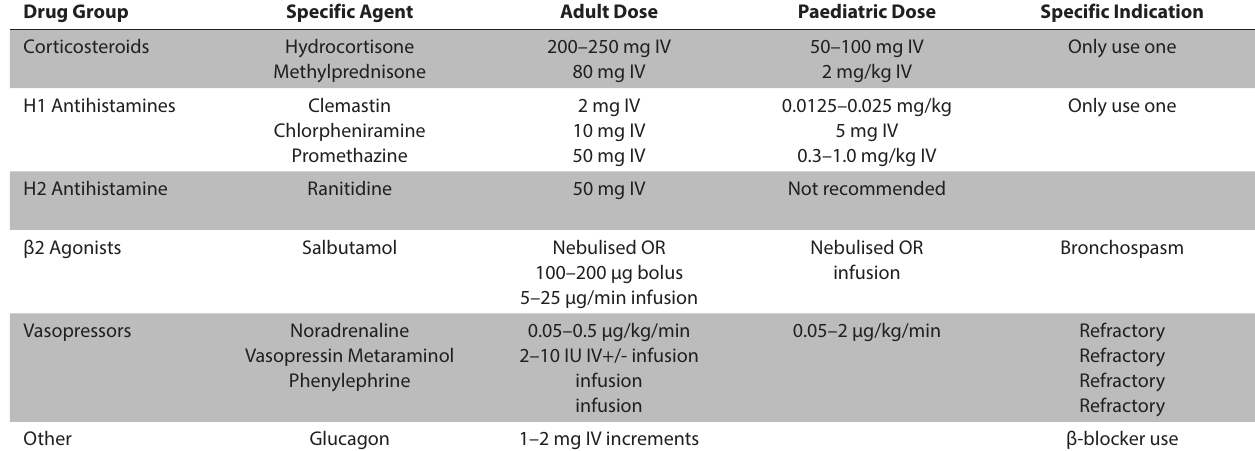
Table 8: Adjuncts Recommended by Perioperative Anaphylaxis Guidelines 38,39,40 Drug Group Specific